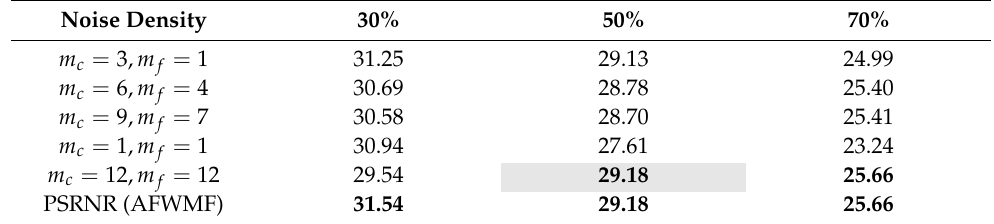
Table 12. The PSNR value for setting parameters by referring to the PSRNR formula (Lena image).